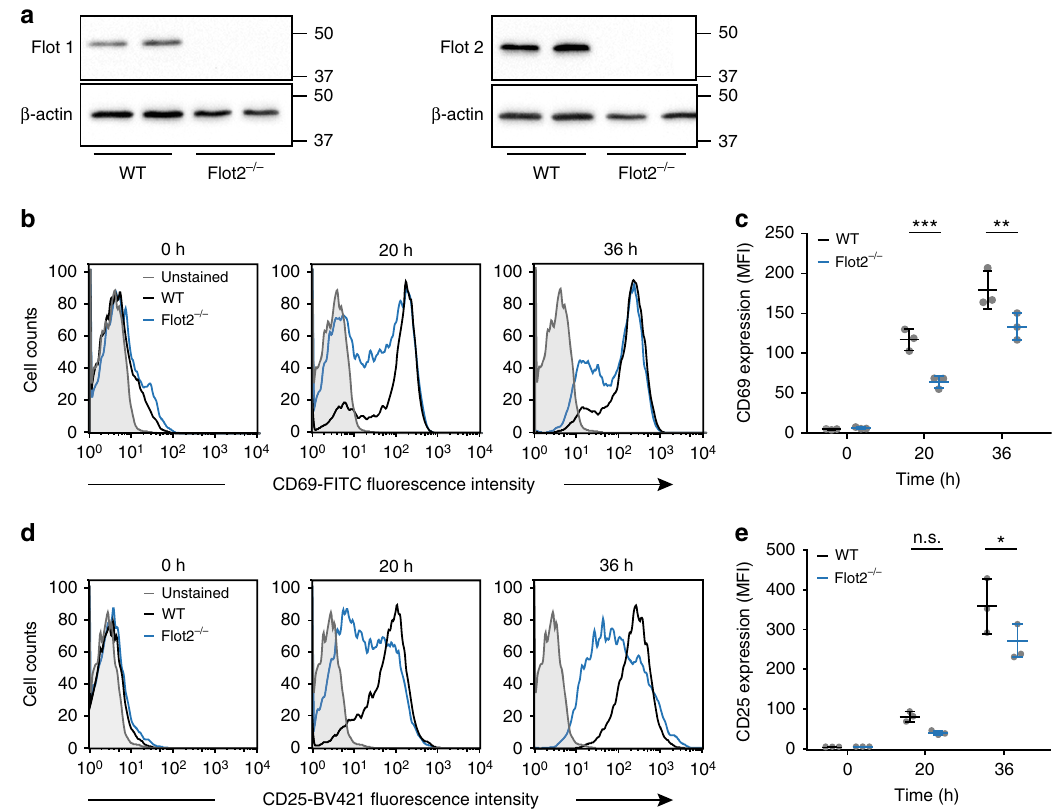
Fig. 8 Flotillin expression is required for activation of mouse primary CD4 T cells. a Western blot of splenocyte lysate from WT and fl otillin2 KO mice probed with antibodies against fl otillin1 and fl otillin2. b – e Representative fl ow cytometry histograms of CD4 T cells isolated from the spleen of WT or fl otillin2 KO mice, activated on anti-CD3 and anti-CD28 surfaces for 20 and 36 h and stained with antibodies against CD69 ( b ) or CD25 ( d ). Mean fl uorescent intensity (MFI) at the surface of 10,000 cells of WT and fl otillin2 KO CD4 T cells stained with antibodies against CD69 ( c ) or CD25 ( e ). Data obtained from three mice for each condition. Error bars indicate mean (±SEM). * p < 0.01; ** p < 0.001; *** p < 0.0001; ANOVA